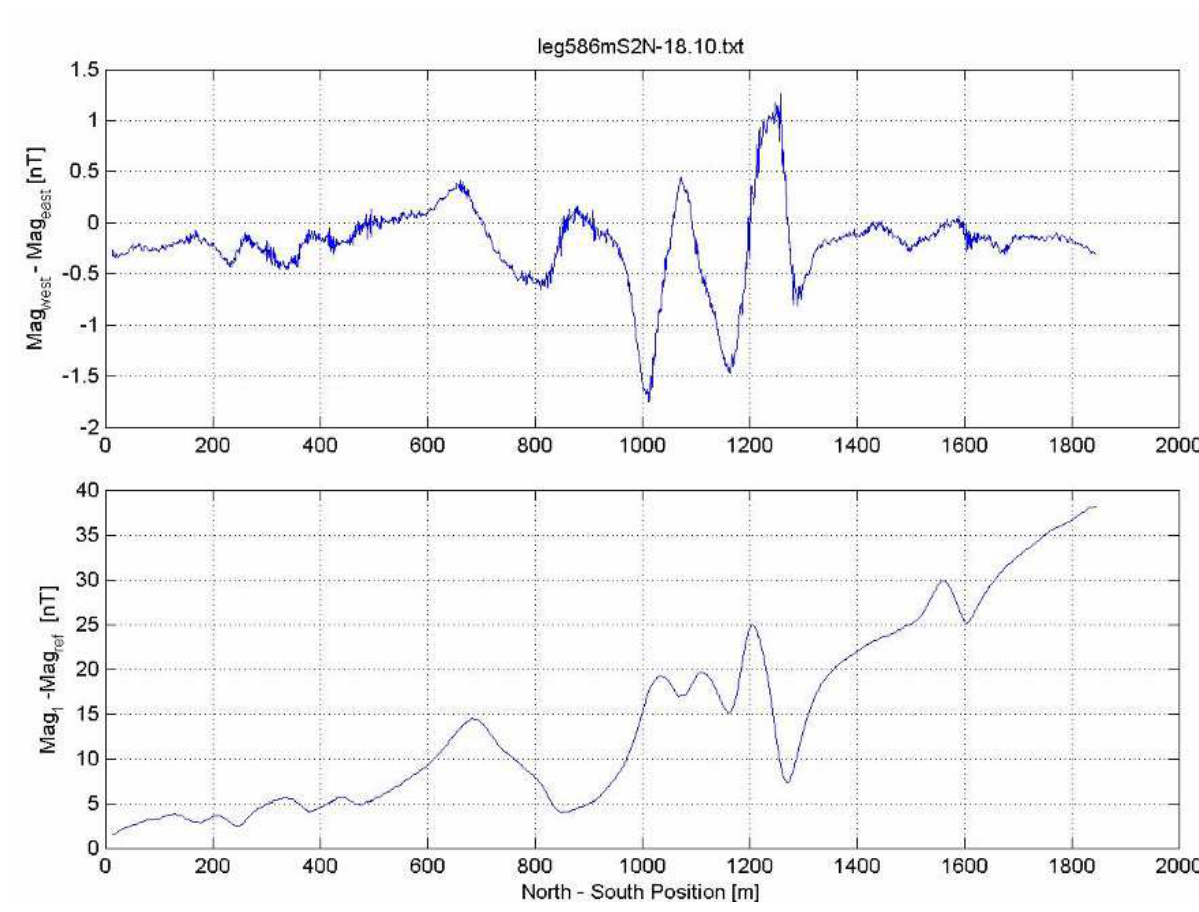
Figure 5. An example of magnetic trace along a survey